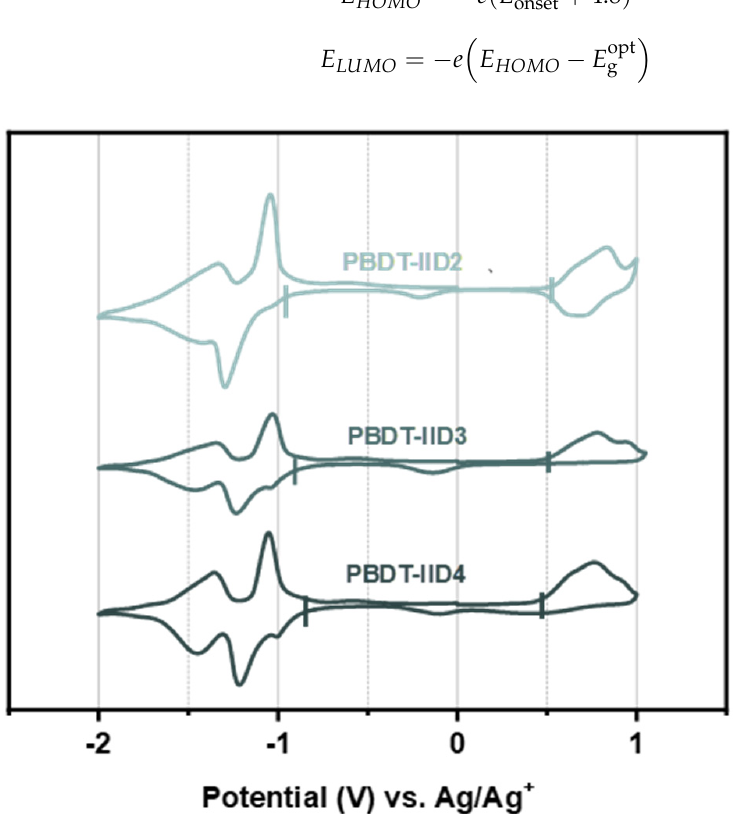
Figure 5. The cyclic voltammetric curves of PBDT-IID2, PBDT-IID3, and PBDT-IID4 (the electrolyte solution is 0.1 M tetrabutylammonium hexafluorophosphonate solution in anhydrous